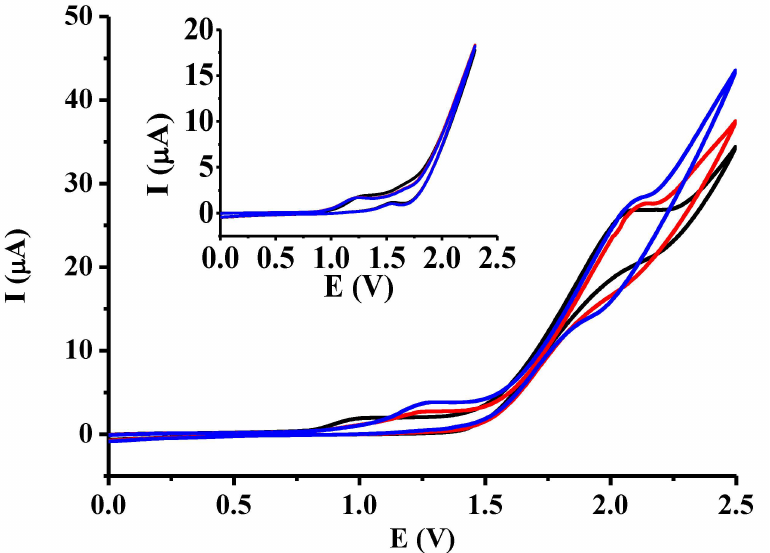
Figure 4. Cyclic voltammograms of 10 mM DBM in the presence of different quantities of the octacarboxyl cavitand in 1-propanol (black curve: 0 mM, red curve: 2.5 mM, blue curve: 5 mM cavitand, scan rate 0.1 V/s, supporting electrolyte 50 mM